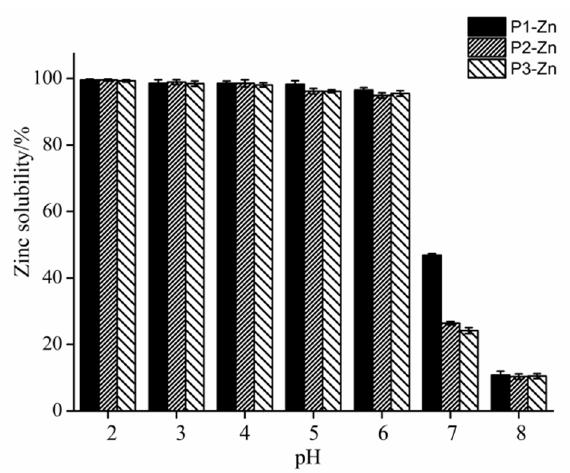
Figure 3. Zinc solubility of three peptide-zinc complexes at various pH values.